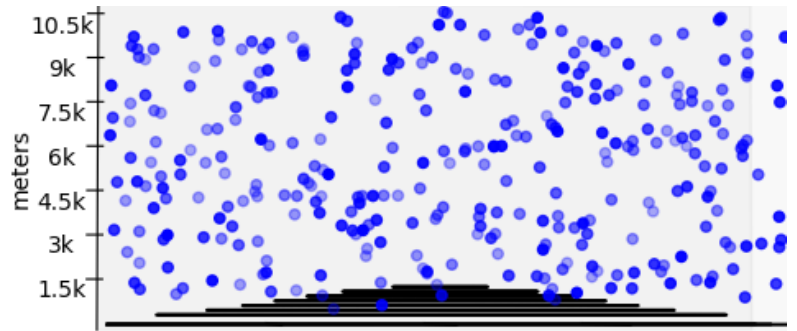
Figure 4. Side view of hill and air